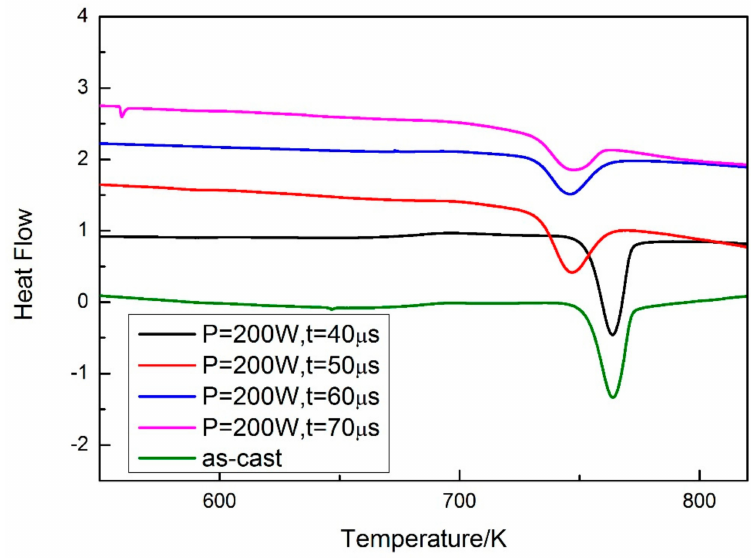
Figure 9. DSC curves of as-cast and SLM specimens.